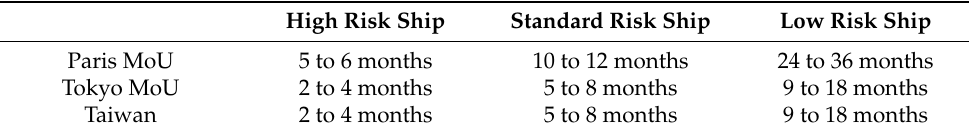
Table 2. Table of exemption times for ships with different risks under NIR regulations.